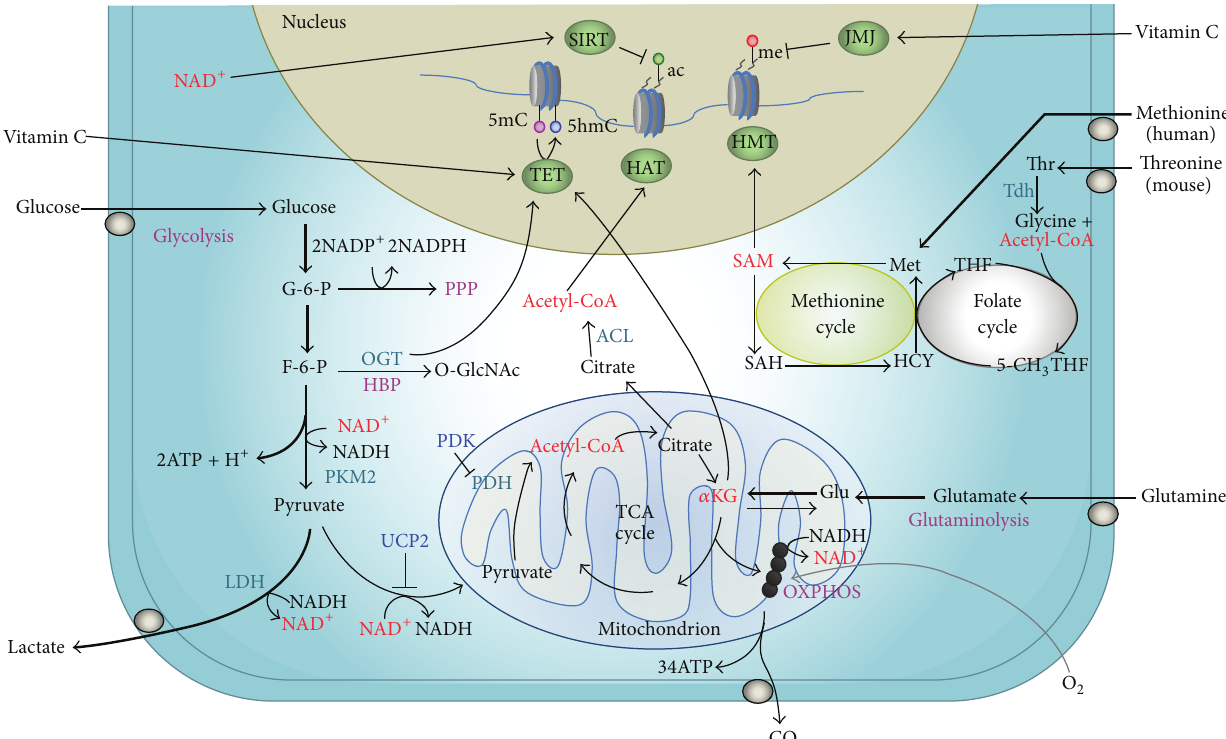
Figure 1: Metabolic regulation of the pluripotent epigenetic landscape. Pluripotent stem cells are characterized by spherical, electron-poor mitochondria, which contain few cristae. These cells rely heavily on glycolysis for ATP generation (thick black arrows), resulting in significant lactate production through the conversion of pyruvate to lactate by lactate dehydrogenase (LDH). Consequently, oxidative phosphorylation (OXPHOS) contributes minimally to total ATP. Glucose metabolized by the pentose phosphate pathway (PPP) generates the ribose moieties required for DNA and RNA synthesis and the NADPH required for the biosynthesis of lipids and other complex molecules. Intermediate metabolites generated via metabolic pathways act as cofactors for epigenetic modifying enzymes. Threonine and methionine metabolism is required for S-adenosyl methionine (SAM) generation via the folate and SAM cycles in mouse and human pluripotent stem cells, respectively [60, 61]. SAM acts as a methyl donor for histone methyltransferases (HMT) as well as DNA methyltransferases. Demethylation of SAM yields S-adenosylhomocysteine (SAH), which is, in turn, hydrolyzed to homocysteine. Transfer of a methyl group to homocysteine from the folate pathway regenerates methionine. Acetyl coenzyme A (Acetyl-CoA) acts as a cofactor for histone acetyltransferases (HAT). Acetyl-CoA, generated from glucose derived pyruvate, modulates human pluripotent stem cell histone acetylation [76], although pyruvate dehydrogenase kinase (PDK) activity may limit the conversion of pyruvate to acetyl-CoA [79]. Similarly, uncoupling protein 2 (UCP2) functions to shunt pyruvate away from the tricarboxylic acid (TCA) cycle, facilitating lactate production [79]. Acetyl-CoA can also be generated from threonine catabolism [62]. Alpha-ketoglutarate ( 𝛼 KG) [65] or supplementation with vitamin C in culture [122] reduces histone and DNA methylation in human pluripotent stem cells, respectively. These metabolites modulate histone and DNA demethylation reactions catalyzed by Jumonji (JMJ) and Ten-Eleven Translocation (TET) demethylases, respectively [101]. The hexosamine biosynthetic pathway (HBP) is an alternative routeofglucoseutilizationthatgeneratesthecoenzymeUDP-GlcNAc,whichtogetherwithO-linkedN-acetylglucosaminetransferase(OGT) leads to histone O-GlcNAcylation [82]. Flux through glycolysis and oxidative phosphorylation determines the NAD + :NADH ratio, known to regulate the activity of the NAD + -dependent histone deacetylases sirtuins (SIRT; [90]). In addition, a proline-dependent mechanism of epigenetic regulation has been reported in pluripotent stem cells [74]; however, it is unclear how the metabolism of proline interacts with these pathways. Metabolic regulators of chromatin-modifying enzymes are highlighted in